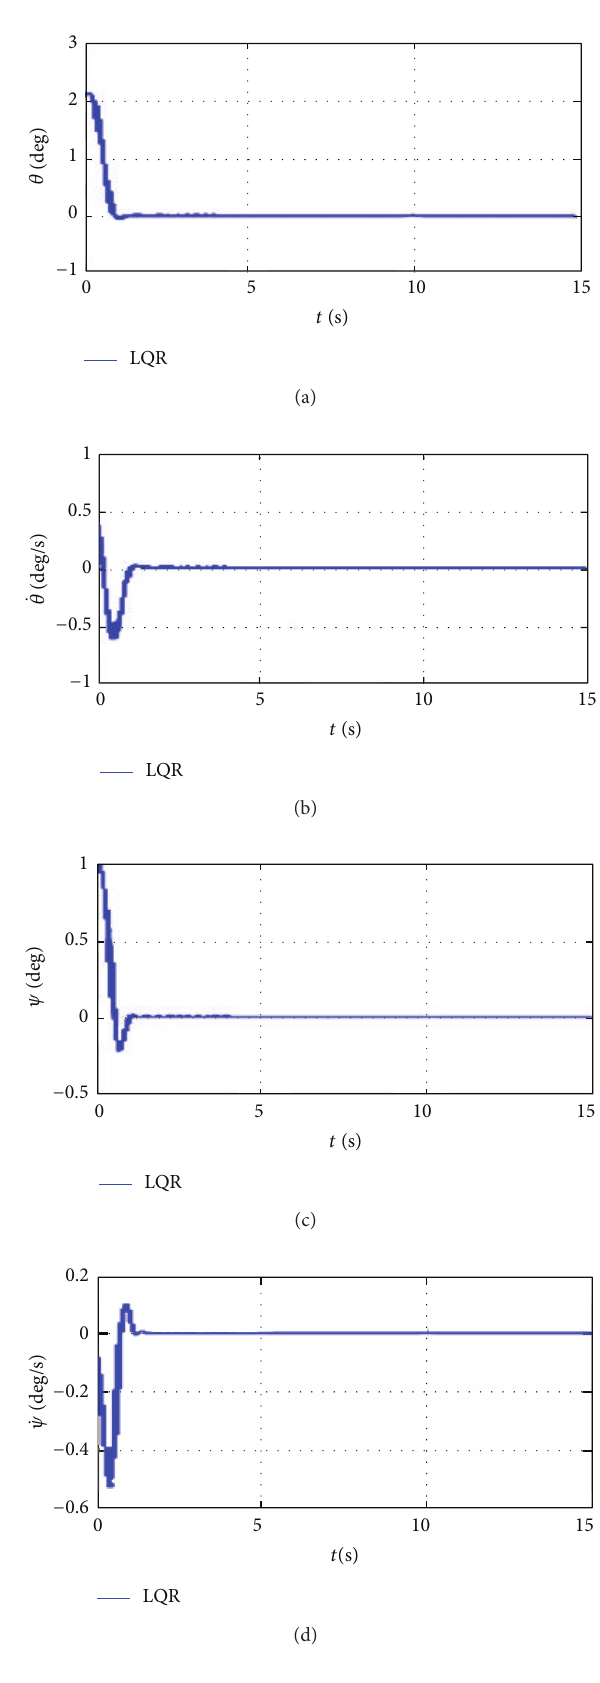
Figure 6: LQR controller during the rod